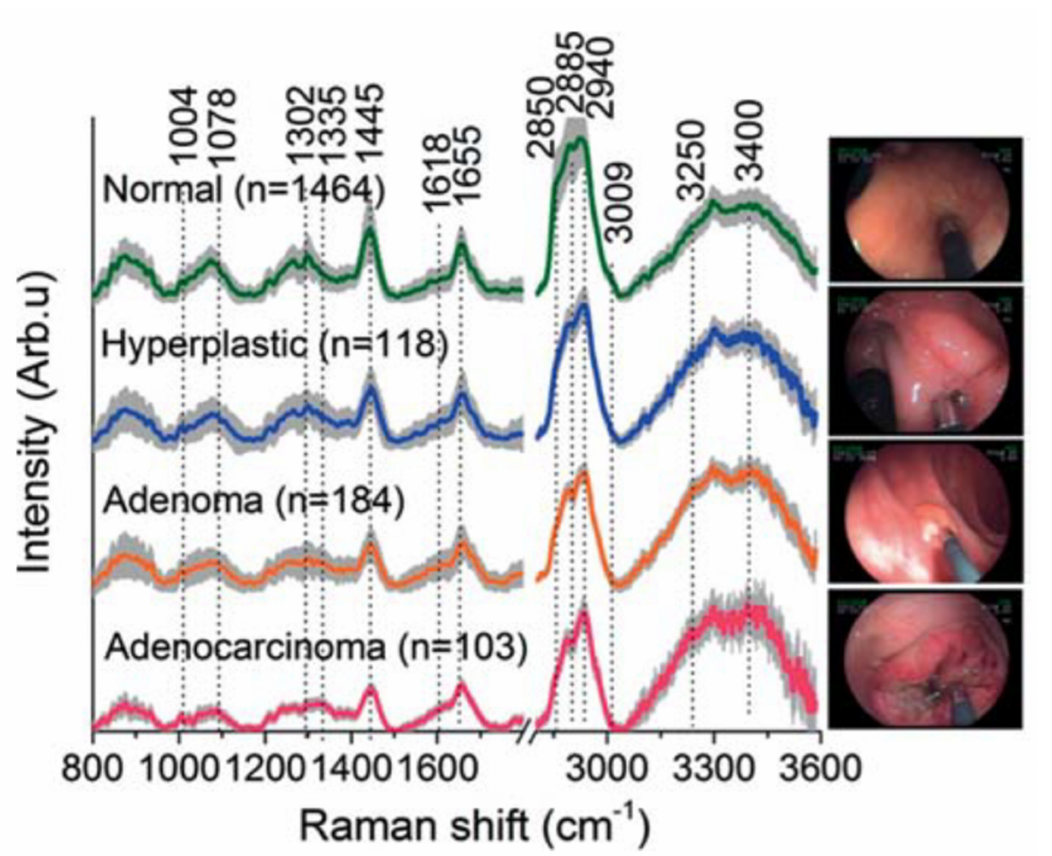
Figure 1. Mean ± 1 standard deviation (SD) values of in vivo fingerprint (FP) spectra (800–1800 cm − 1 ) and high-wavenumber (HW) Raman spectra (2800 − 3600 cm − 1 ) of normal ( n = 1464), hyperplastic polyps ( n = 118), adenoma ( n = 184), and adenocarcinoma ( n = 103) acquired from 121 lesions of 50 patients during colorectal endoscopy. The spectra have been normalized to the integrated area in the FP and HW ranges for comparison purpose. Reused with permission from [55]. Copyright